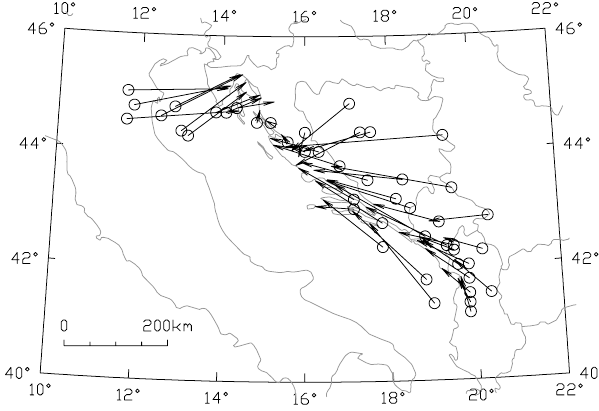
Figure 1. Illyricum : residual plot after a conversion Λ 0 = Λ+ λ SA in longitude with λ SA = − 25 ◦ 10 0 ( point : ( Λ 0 , Φ ), arrowhead : ( λ,φ )). shown in Fig. 1. They have varying directions and often mag- ◦ nitudes of 2 ◦ to 3 ◦ in longitude and 1 to 1 ◦ in latitude. How- 2 ever, there are also vectors which are similar to each other. That indicates systematic errors